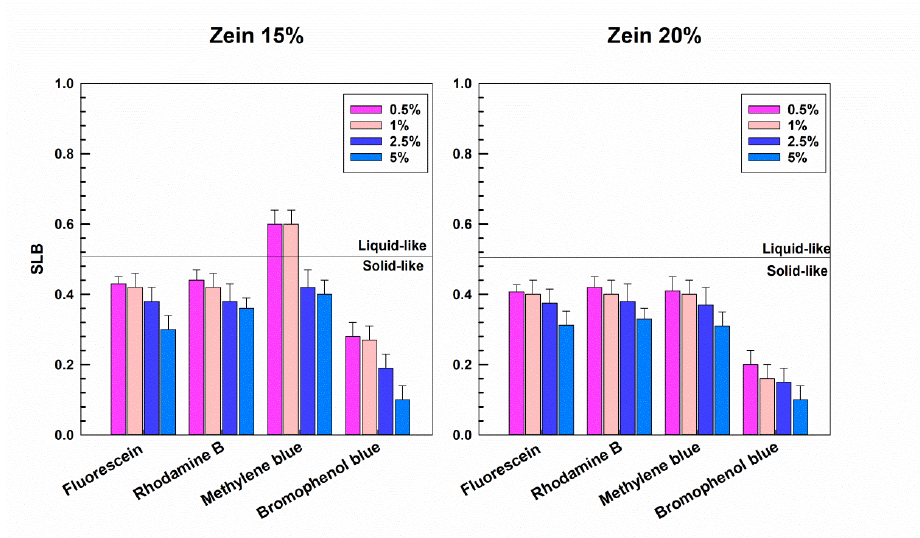
Figure 11. Values of the solid–liquid balance (SLB) of zein gels containing various compounds characterized by different physico-chemical properties as a function of the biopolymer concentration and the amount of probe used during the preparation of samples.